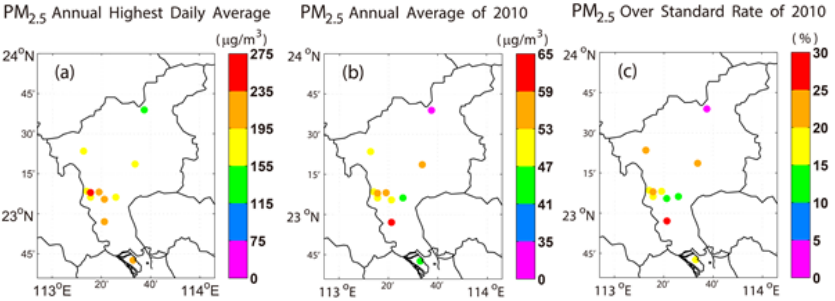
Fig. 5. PM 2 . 5 concentration (µgm − 3 ) at each of the 11 individual sites in Guangzhou region in 2010 of (a) the annual highest daily average, (b) the annual average and (c) over-standard rate.